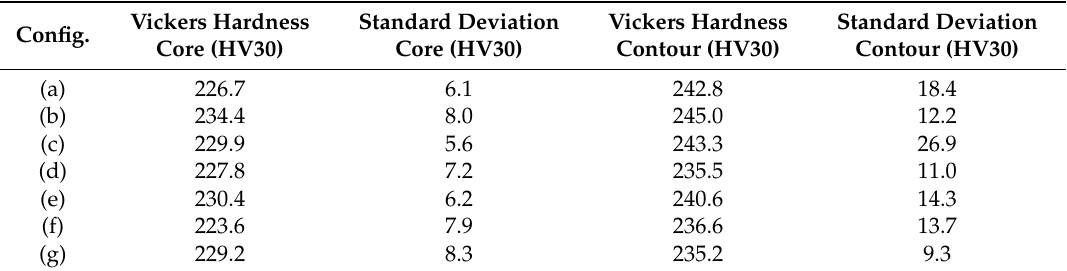
Table 5. Hardness results for 1.4404, comparison between literature and supplier specification; relative densities ( ≥ 99%).